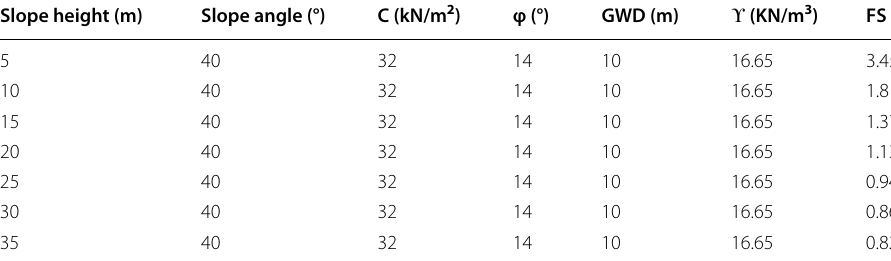
Table 9 Consequence of slope height on its factor of safety